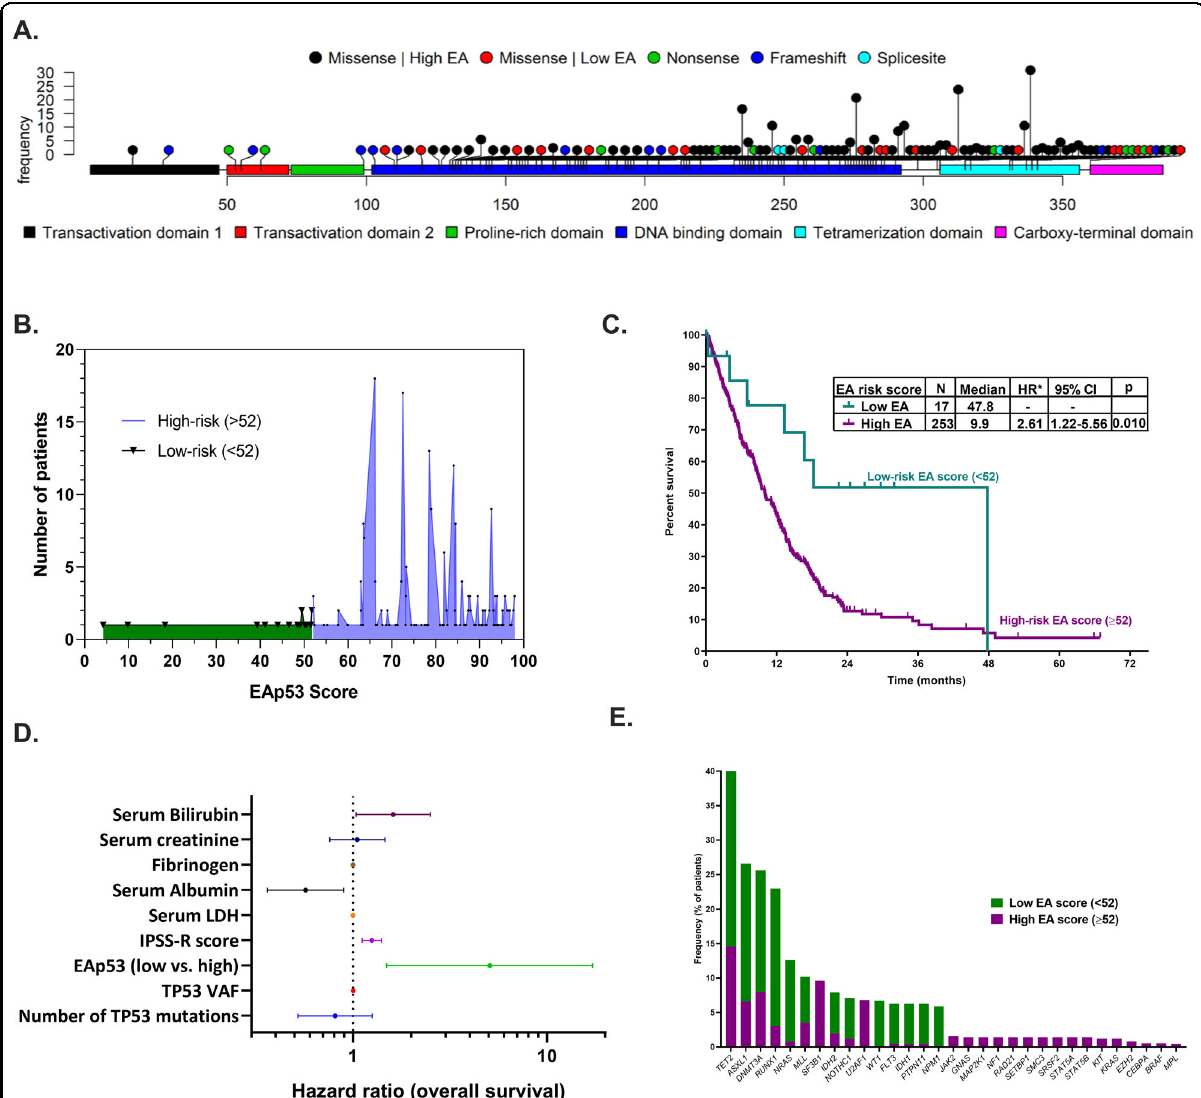
Fig. 1 Correlations between EAp53 score and TP53 mutational characteristics, clinicopathologic features and outcome. A Lollipop plot showing the frequency distribution of missense TP53 mutations and associated concurrent non-missense mutations. B Spectrum of EAp53 scores of the TP53 mutations noted within our MDS cohort: the majority had a high (>52) EAp53 score. C Using RPART, an EAp53 score of 52 provided an optimal cut-off based on overall survival in MDS patients. D The multivariate model identi fi ed EAp53 score, R-IPSS risk score, and serum bilirubin to be an independent predictor for worse overall survival. E Mutational frequencies of genes in the cohort separated by EAp53 risk category. Low-risk EAp53 MDS patients had a signi fi cantly higher frequency of mutations in NRAS and RUNX1 , and a trend for higher frequencies in NPM1 , WT1 , and ASXL1